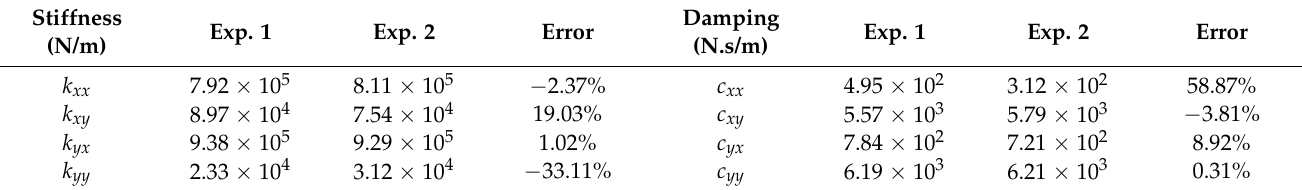
Table 6. Percentage deviations of the calculated natural frequencies.